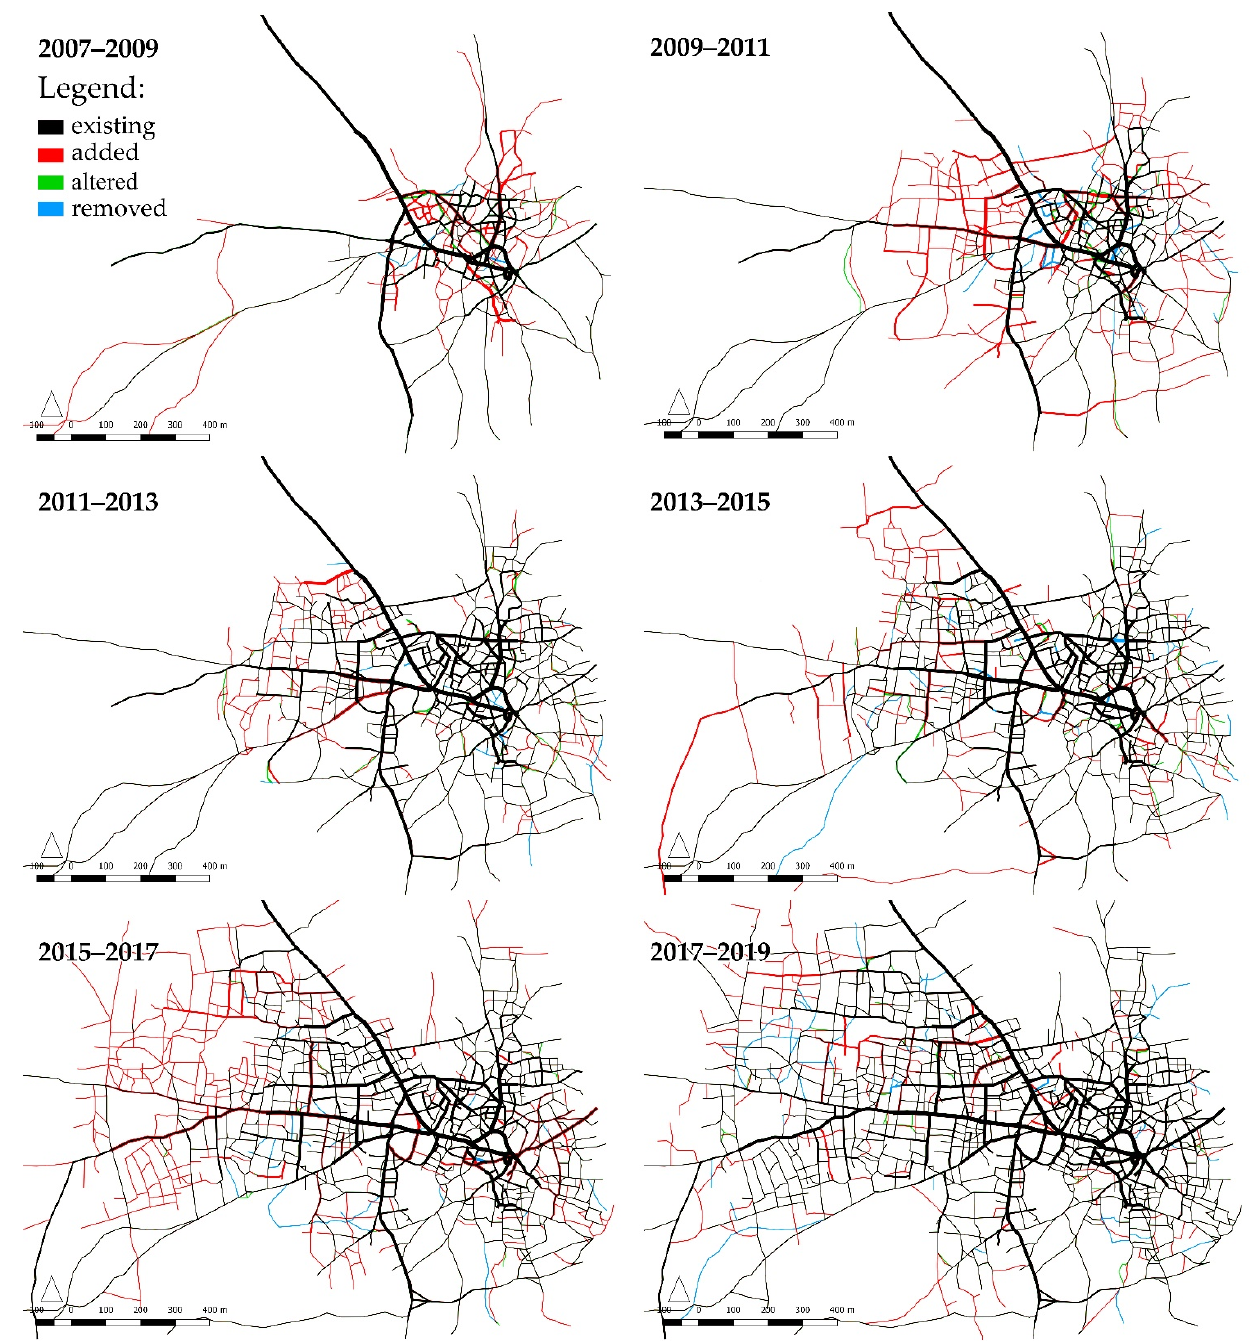
Figure 2. Mapping the emerging access network.